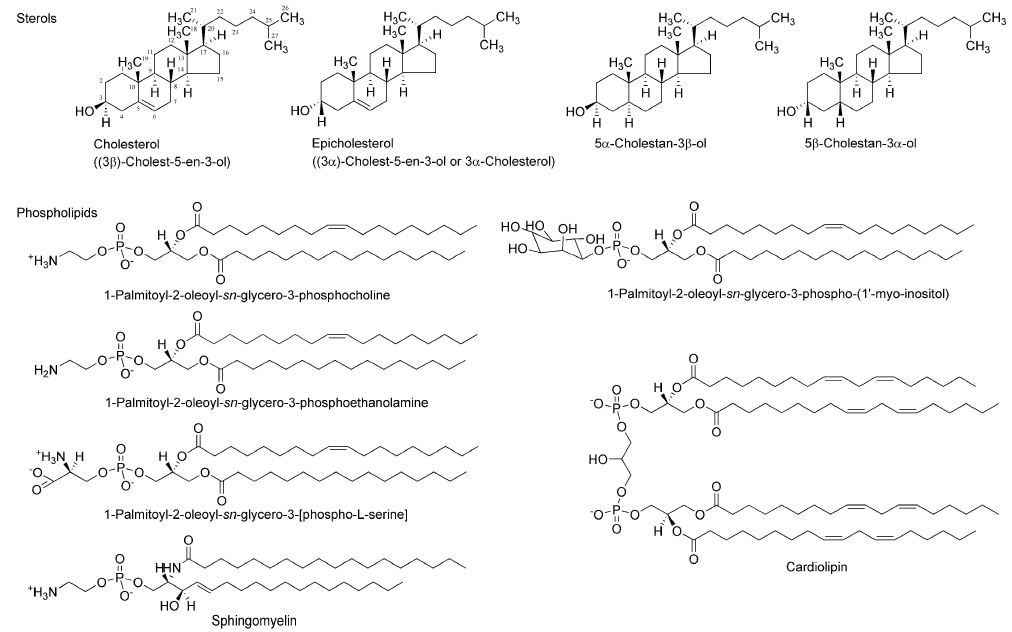
Figure 2. Membrane-constituting chiral phospholipids and